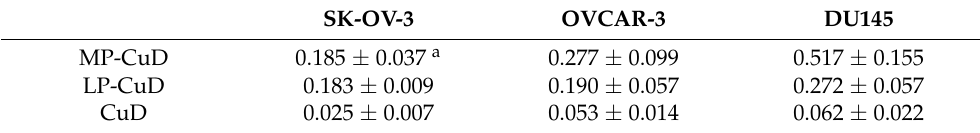
Table 3. Cytostatic activity of the polymer conjugates carrying CuD in selected human tumor cells.